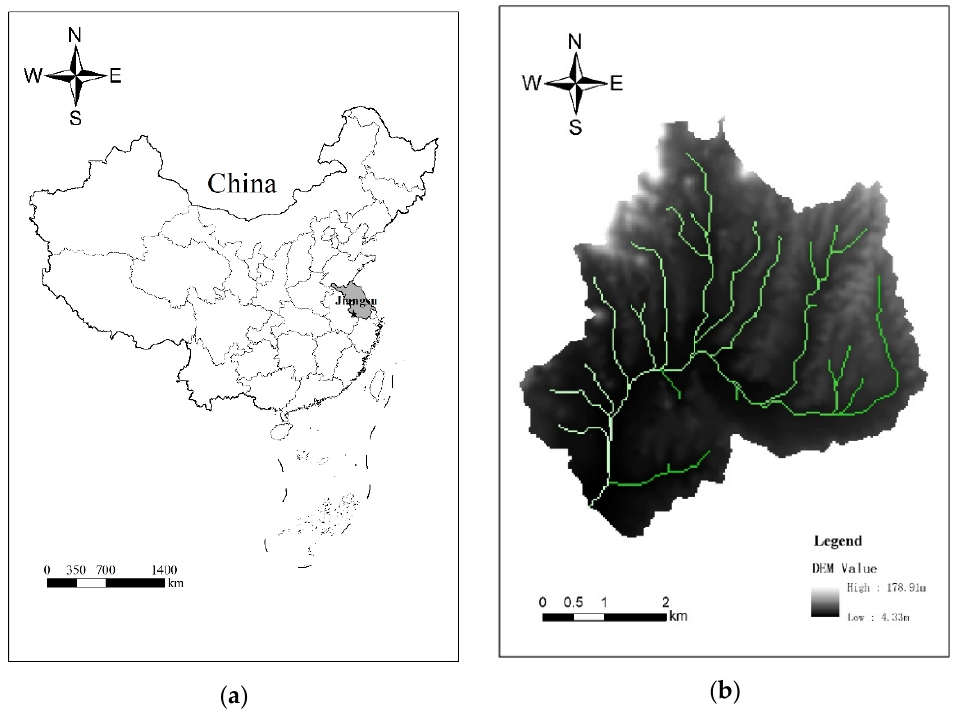
Figure 2. ( a ) Location of Peiqiao River watershed in China; ( b ) DEM feature of Peiqiao River wa- tershed.